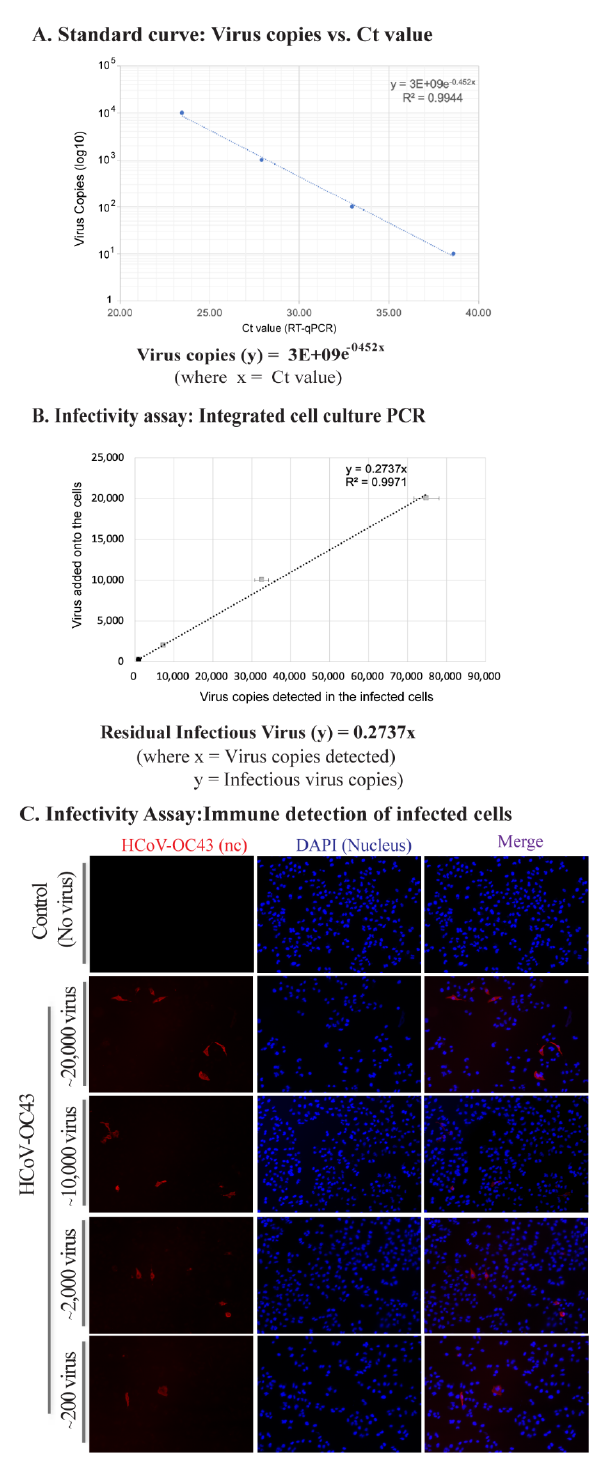
Figure 2. Assay establishment: Integrated cell culture PCR and immune detection of HCoV-OC43 in- fected cells. ( A ) Standard curve of varying HCoV-OC43 genome copies with Ct value. ( B ) Correlation of HCoV-OC43 viral copies added onto A549-hACE2 cells and detection of intracellular viral genome copies following infection and replication. ( C ) Immune localization of HCoV-OC43 nucleocapsid protein in A549-hACE2 cells infected with varying amounts of virus. Nucleocapsid was detected with anti-HCoV-OC43 antibody followed by staining with chicken anti-mouse Alexa Fluor 594 (red). Nuclei were stained with DAPI